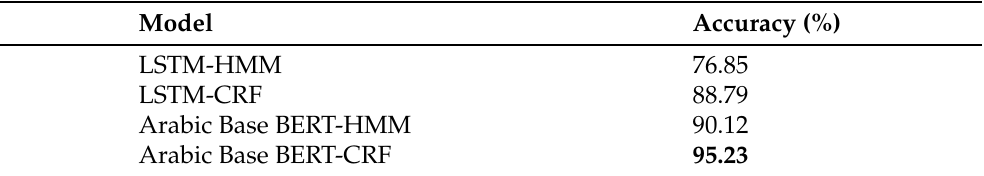
Table 6. Error analysis of Arabic base BERT-CRF